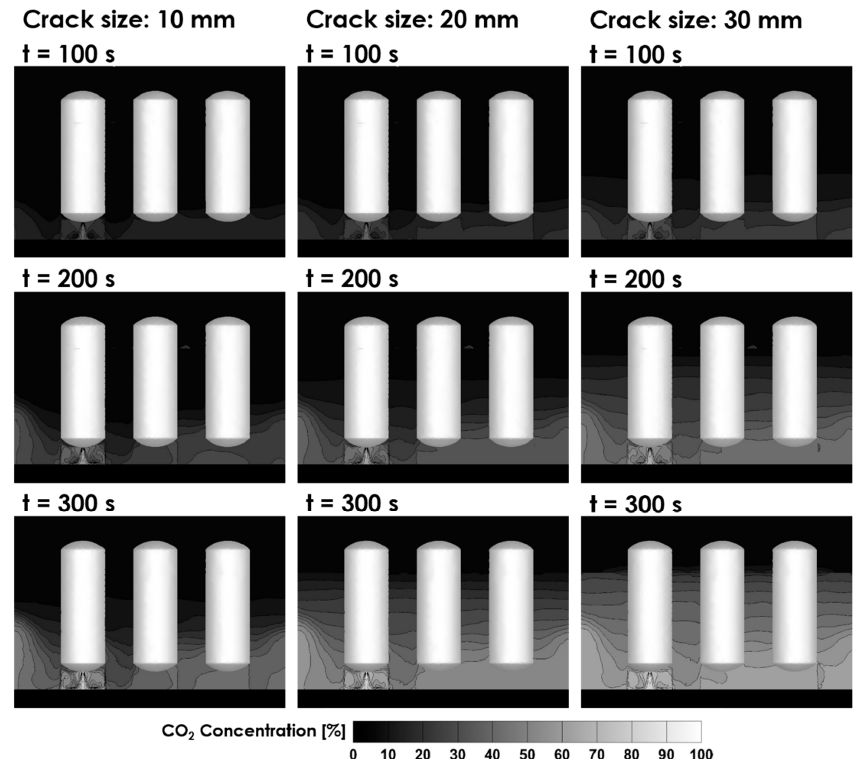
Figure 7. CO 2 concentration distribution at the cross-sectional plane passing through the crack. Appl. Sci. 2018 , 8 , x FOR PEER REVIEW